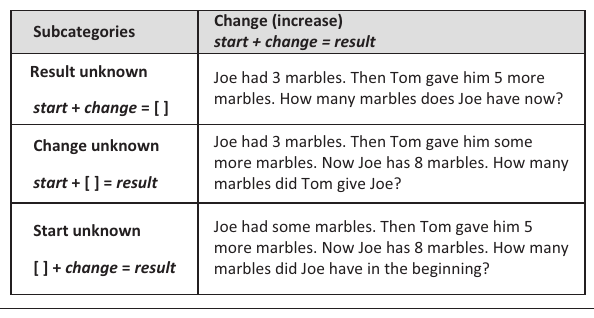
FIGURE 4: Subcategories created by changing direction of action or comparison.